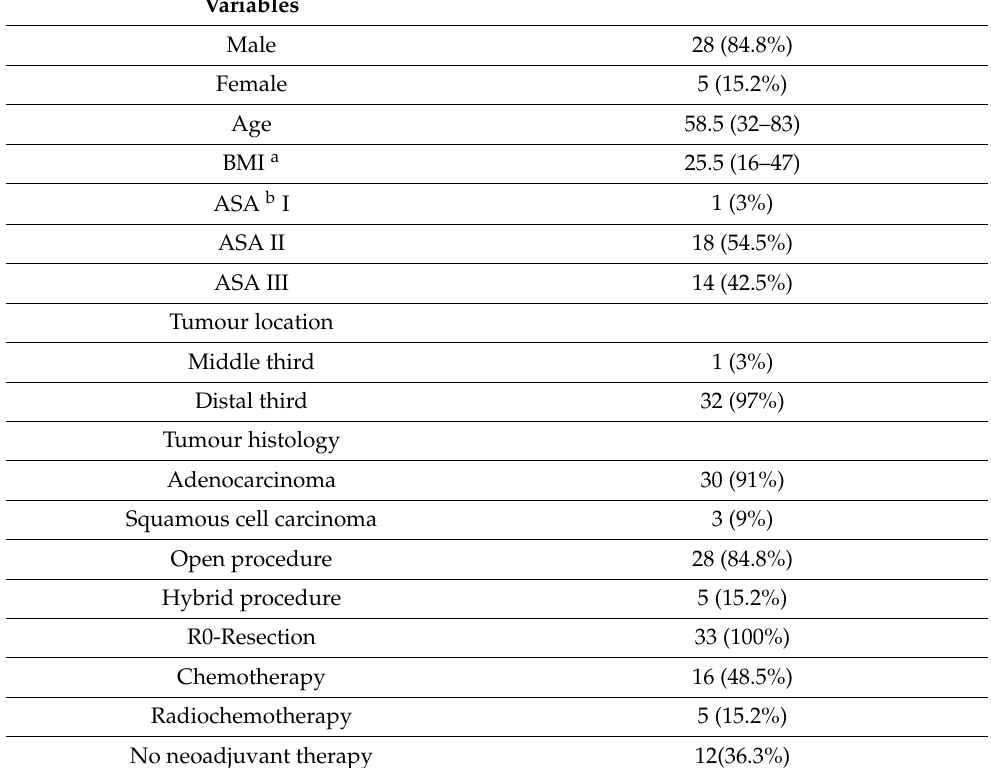
Table 1. Patient and tumour characteristics.